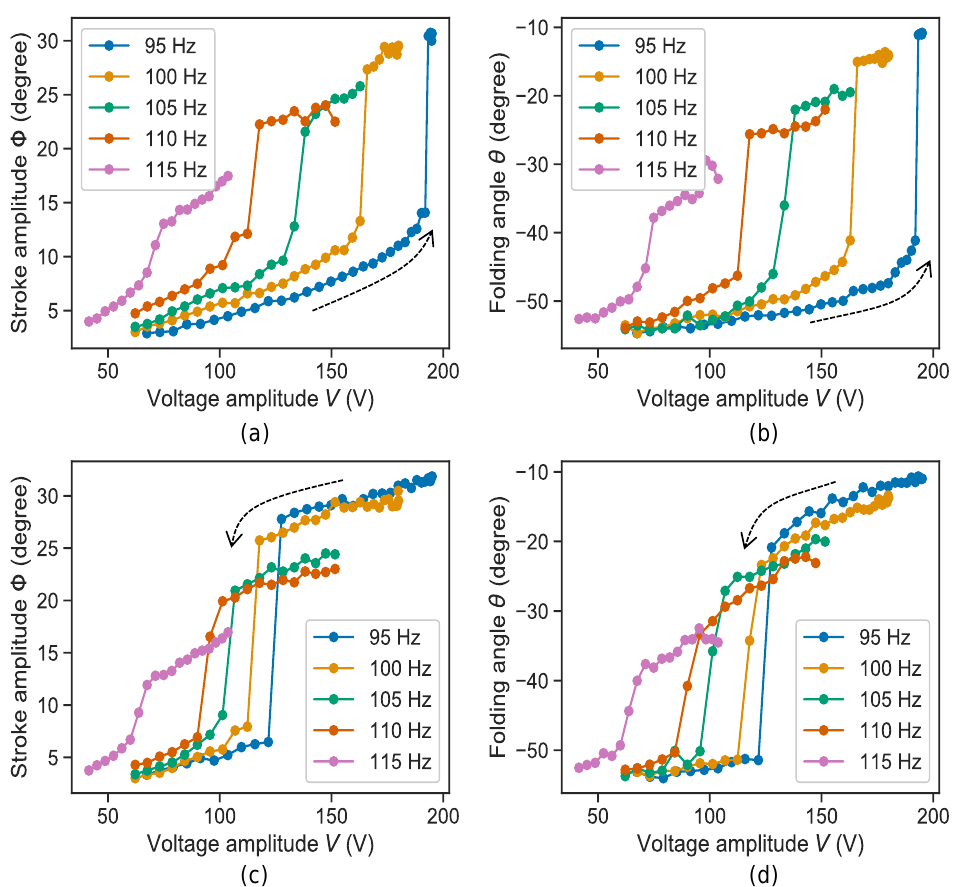
Figure 6. Characteristics of stroke amplitude and folding angle on frequency: ( a ) stroke amplitude and ( b ) folding angle with increasing applied voltage amplitude; ( c ) stroke amplitude and ( d ) folding angle with decreasing applied voltage amplitude.